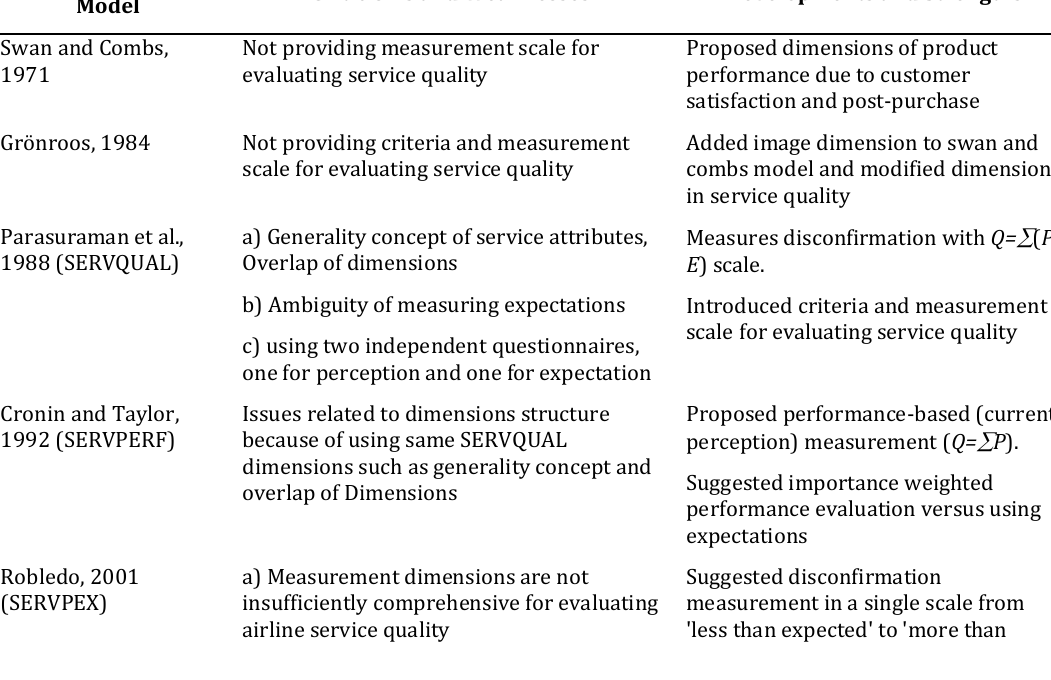
Table 1: Weaknesses and Strengths of Service Quality